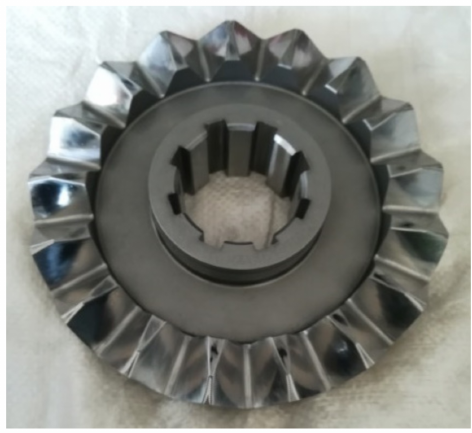
Figure 11. Face gear after